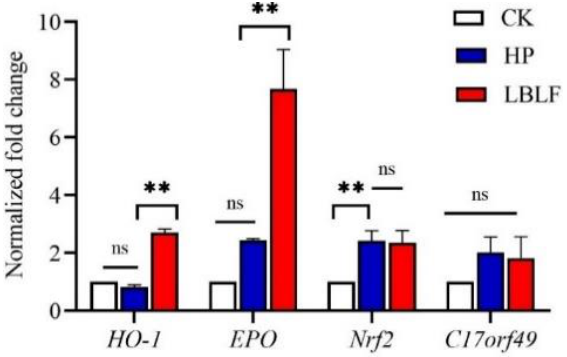
Figure 5. Validation of RNA-Seq data by RT-PCR. ** in the Figure represents extremely significant differences in expression levels at different stages ( p < 0.01). Lowercase letters ns in the Figure represent unsignificant differences in expression levels at different stages ( p > 0.05). Three RT-PCR analyses were conducted with each of three independent biological replicates and the data were analyzed using one-way analysis of variance (ANOVA). White, blue, and red represent the control group (CK), 150 μM H 2 O 2 treatment group (HP), and 150 μM H 2 O 2 and 100 µg/mL LBLF cotreated group (LBLF), respectively.